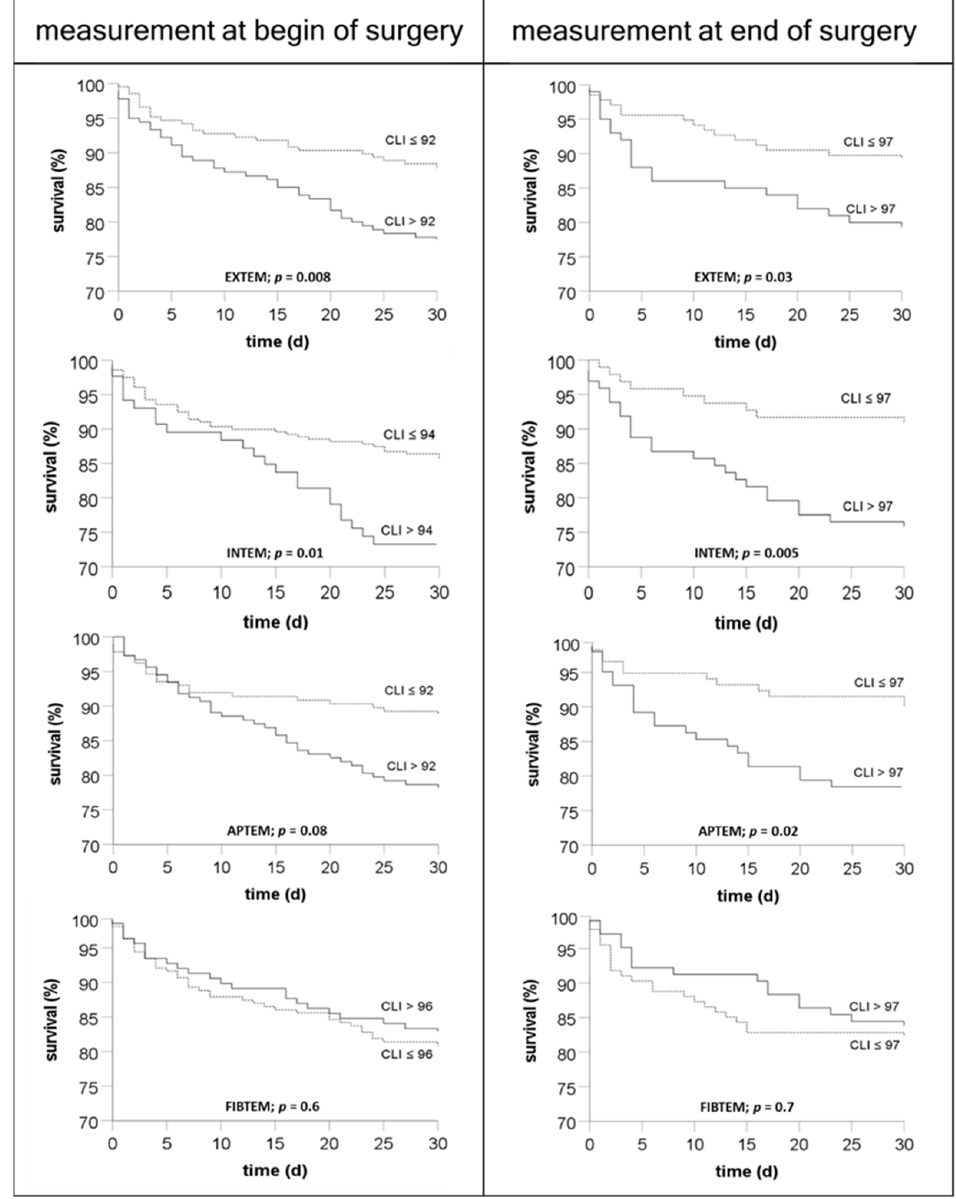
Figure 5. Association of ROTEM™ clot lysis indices obtained from patients at the beginning and the end of liver transplantation with 30-day-survival. Results demonstrate that a clot lysis index higher than the median in the EXTEM, INTEM, and APTEM test is associated with reduced survival. Inhibition of clot retraction using cytochalasin D in the FIBTEM test resulted in a loss of the association of clot lysis index with mortality. For statistical evaluation the log-rank test was used.